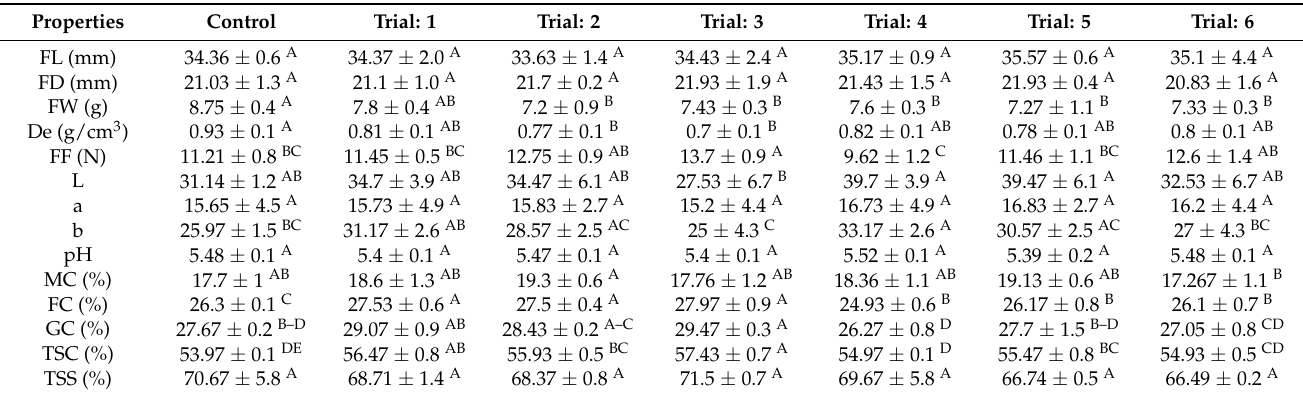
Table 7. Physicochemical properties of artificially ripened date fruits under different trial conditions compared to naturally ripe dates